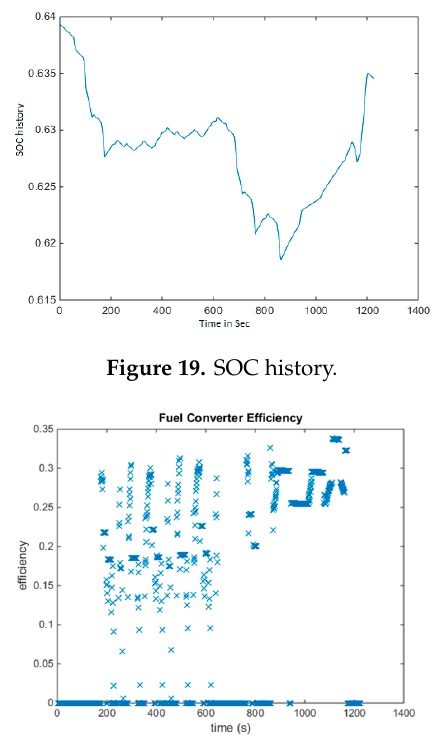
Figure 20. Fuel converter efficiency.